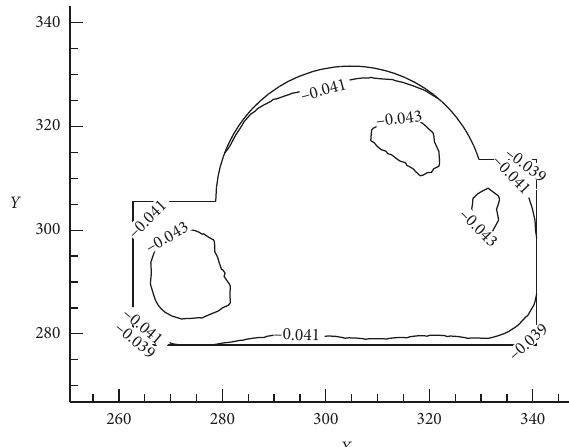
Figure 9: Settlement contour plots of rafts with different pile diameters (scheme 1)